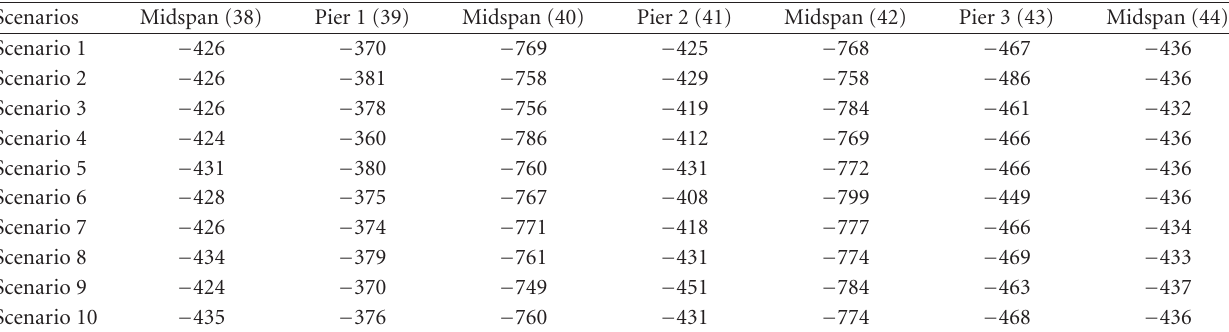
Table 12: Total stresses based on sensor readings—north (psi ∗